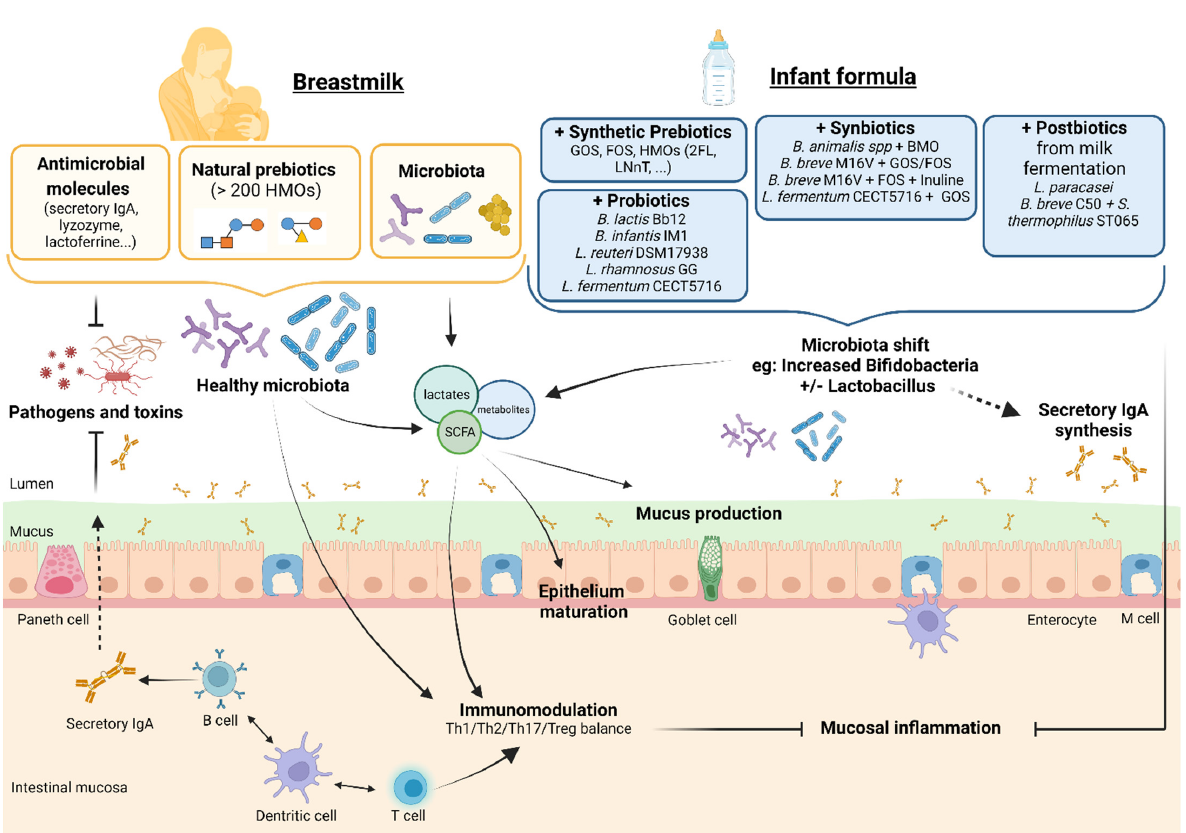
Figure 2. Supposed effects on the intestinal barrier, immunity, and microbiota of infant formula supplemented with pre ‐ , pro ‐ , syn ‐ , and postbiotics compared to breastfeeding. Legend: BMOs—bovine ‐ milk ‐ derived oligosaccharides; FOSs—fructo ‐ oligosaccharides; GOSs—galacto ‐ oligosaccha ‐ rides; HMOs—human milk oligosaccharides.